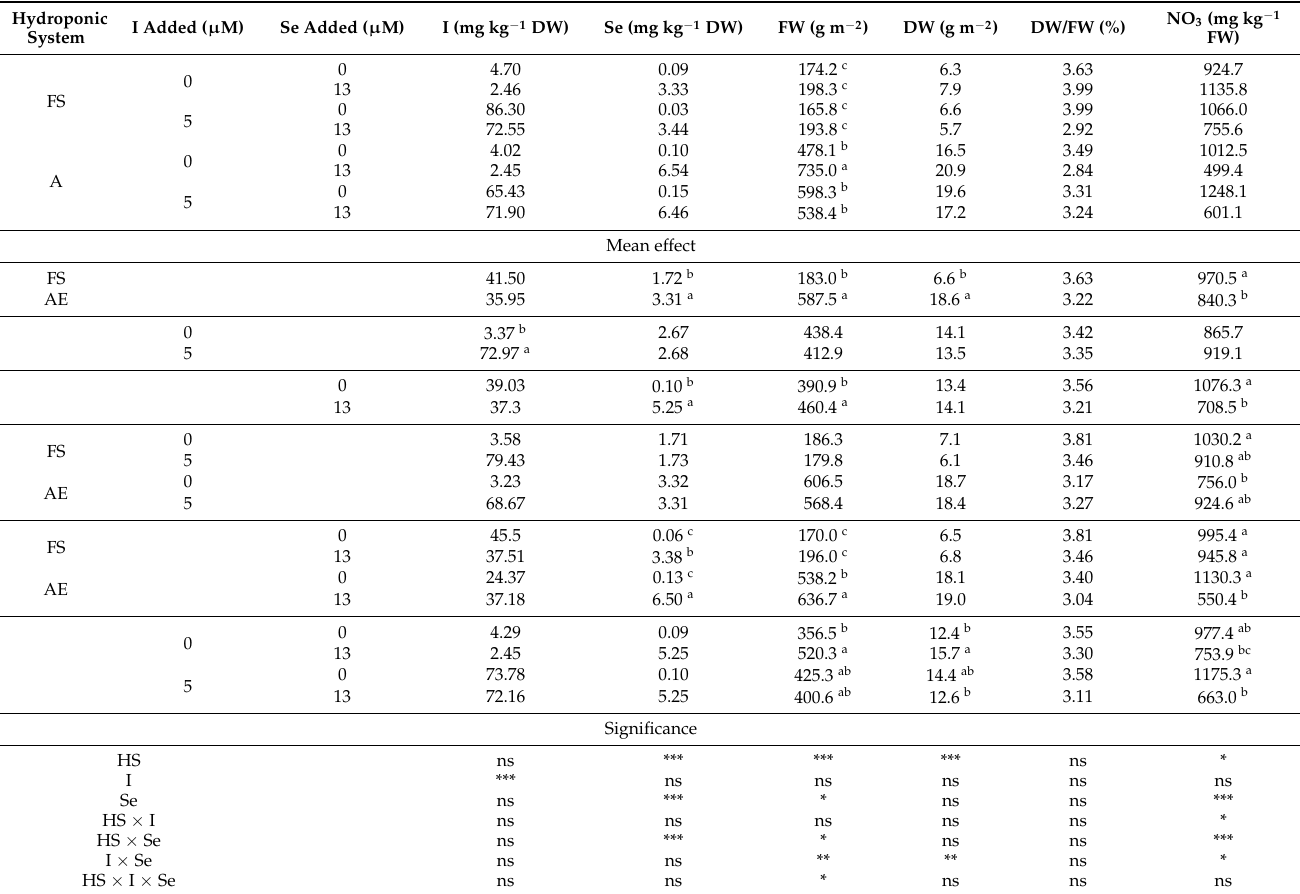
Table 1. Iodine (I) and selenium (Se) content, fresh (FW) and dry (DW) weight, dry matter percentage (DW/FW), and nitrate (NO 3 ) content in leaves of lettuce plants grown in two different hydroponic systems (HS), floating (FS) and aeroponics (AE), and at different concentrations of I and Se in the nutrient solution, in the first